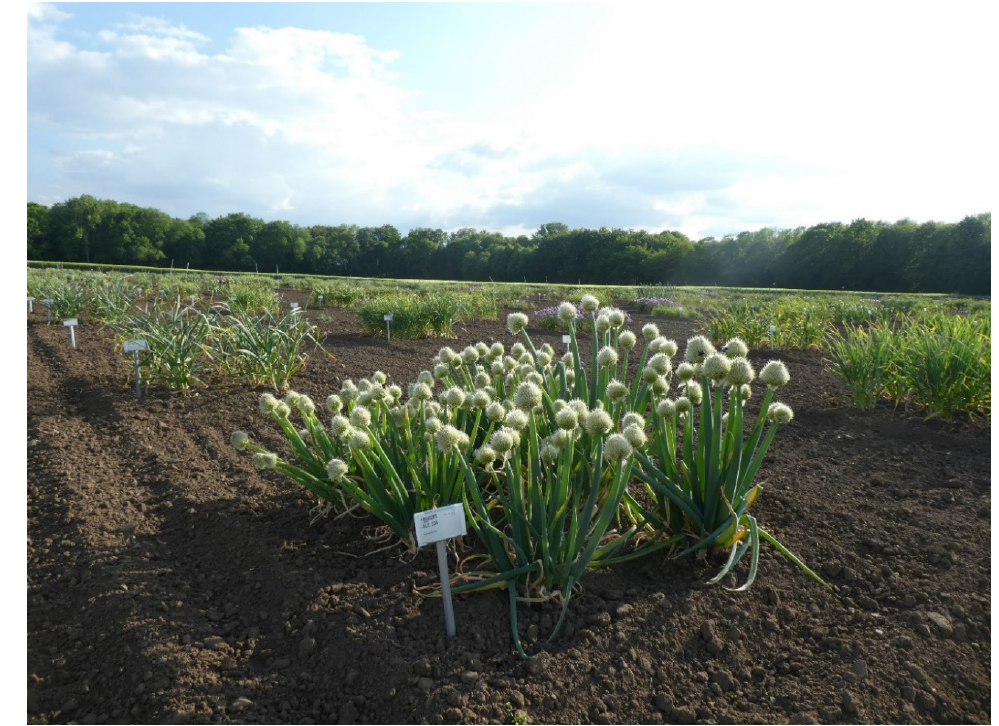
Figure 2. Allium field collection at IPK, Germany.